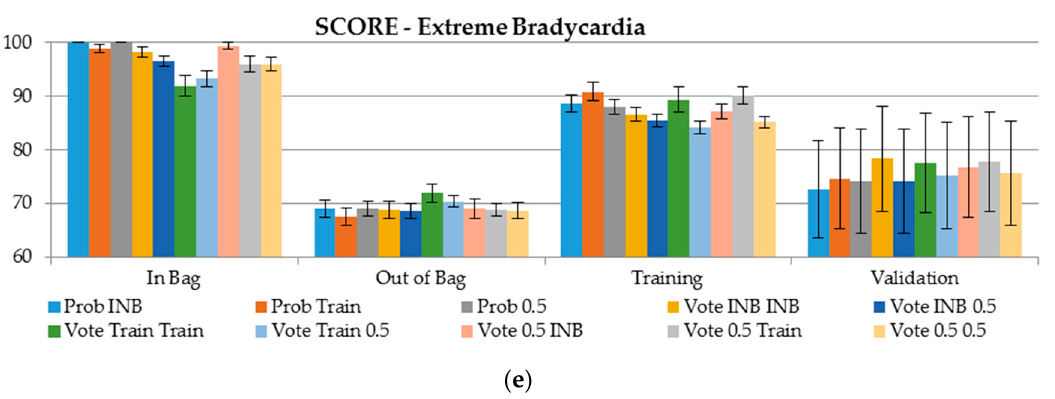
Figure 4. Score results for each type of arrhythmia and sample in terms of method of class label determining. ( a ) Asystole, ( b ) Ventricular Tachycardia, ( c ) Ventricular Fibrillation, ( d ) Extreme Tachycardia, ( e ) Extreme Bradycardia.